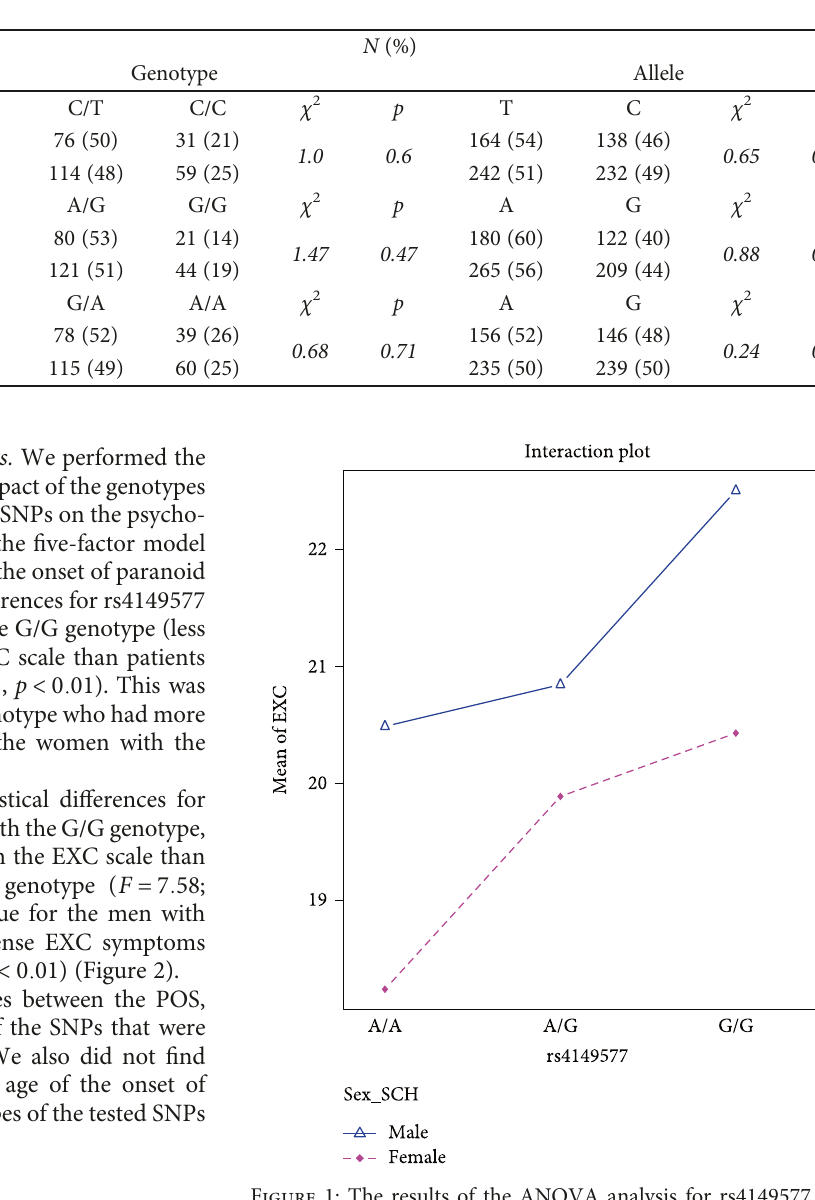
Table 3: Genotype and allele distributions for the TNFR1 (rs4149576, rs4149577, and rs1860545) SNPs in women and men with paranoid schizophrenia.